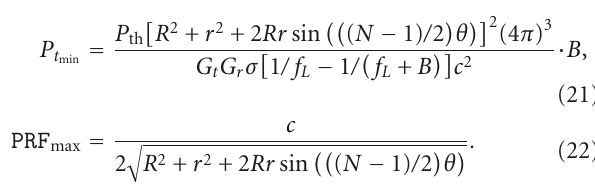
Figure 8: Configuration of N receiving nodes (for even N ). The surveillance area A is the radius- R circle, while the transmitter and the receivers are distributed on a radius- r circle. The angle θ is the same for each pair of contiguous RX nodes and can range between 0 and π/ ( N − 1).